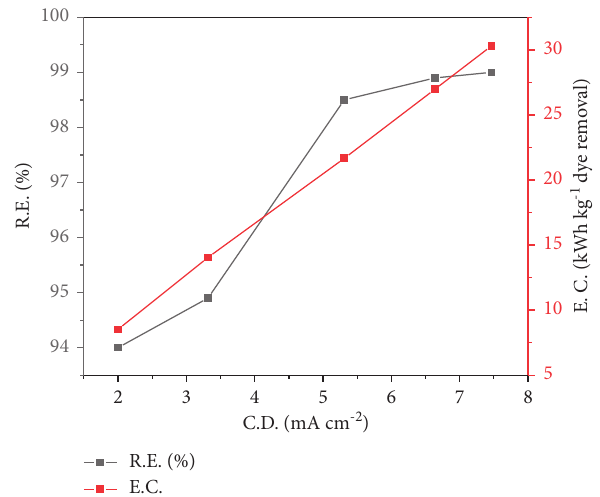
Figure 8: Current density effect on energy consumption and dye removal efficiency (NaCl concentration 1500ppm and EC time 60min).